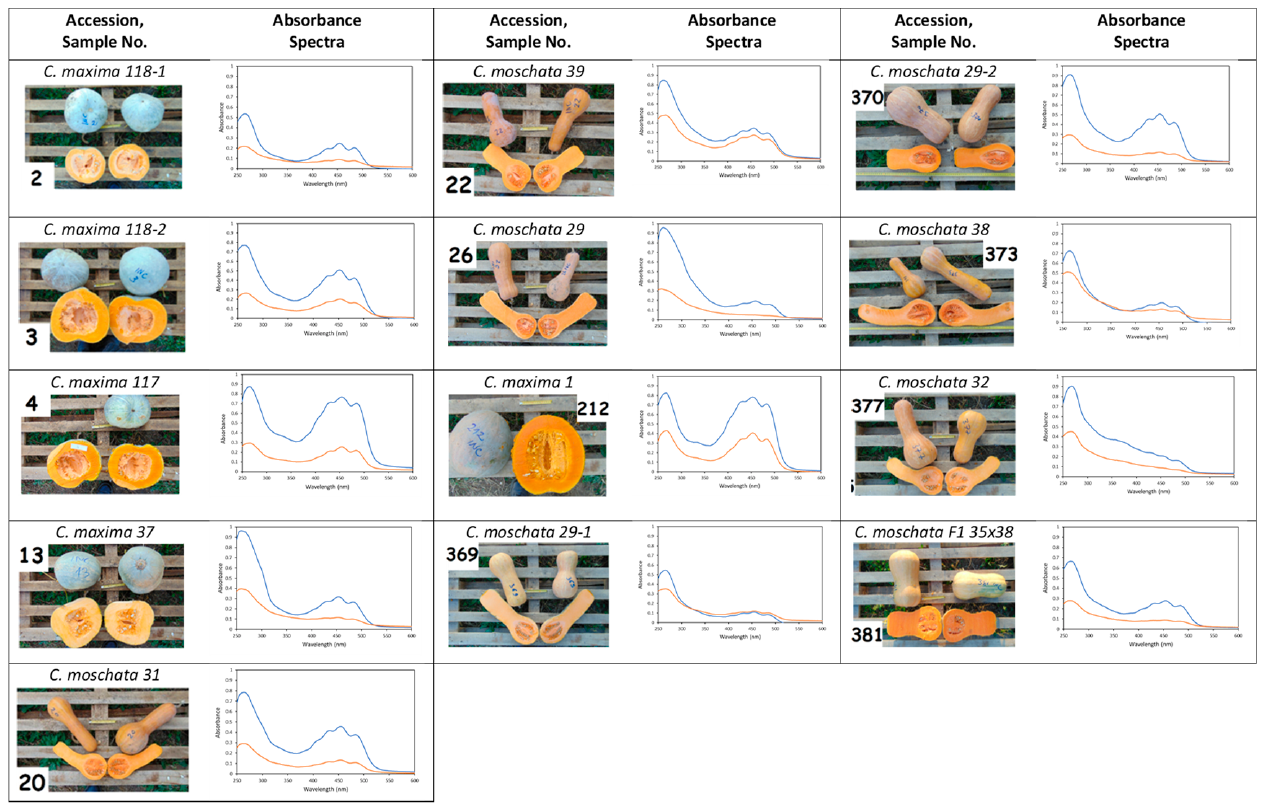
Figure 1. Pumpkins collected or bred in Serbia: images, sample number (in bold) associated with plot number in which each variety was grown, and absorbance spectra (blue line = 1st extraction; orange line = 2nd extraction. See Section 2.3). The absorbance spectra cover the absorbance value ranging from 0 to 1 (increments of 0.1) and from 250 to 600 nm (increments of 50 nm). Pumpkin calibres are more clearly visualized in Figure S1 (Supplementary material) and weight, length, and diameter are reported in Table S3 (Supplementary material).